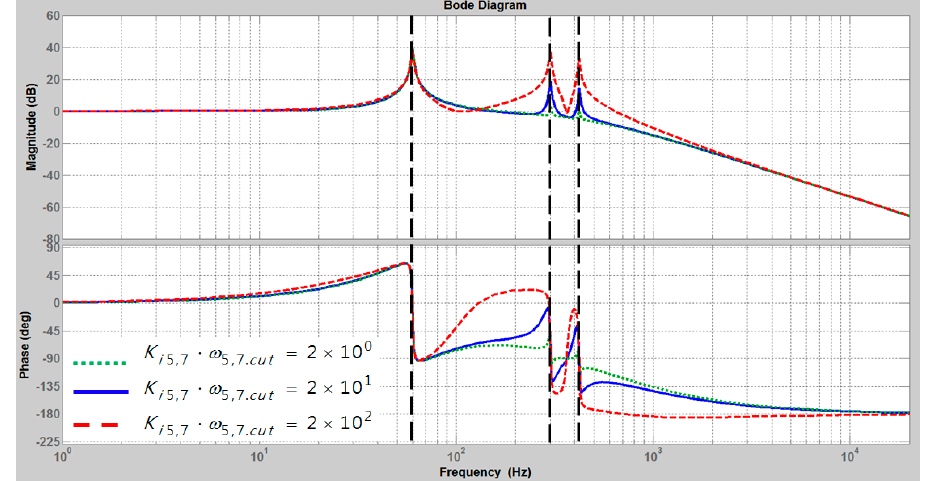
Figure 5. Bode plot of the P+MR based voltage controller with harmonics compensation: K p = 0.0577, K i. 1 · ω 1 .cut = 30, K i. 5,7 · ω 5,7 .cut =